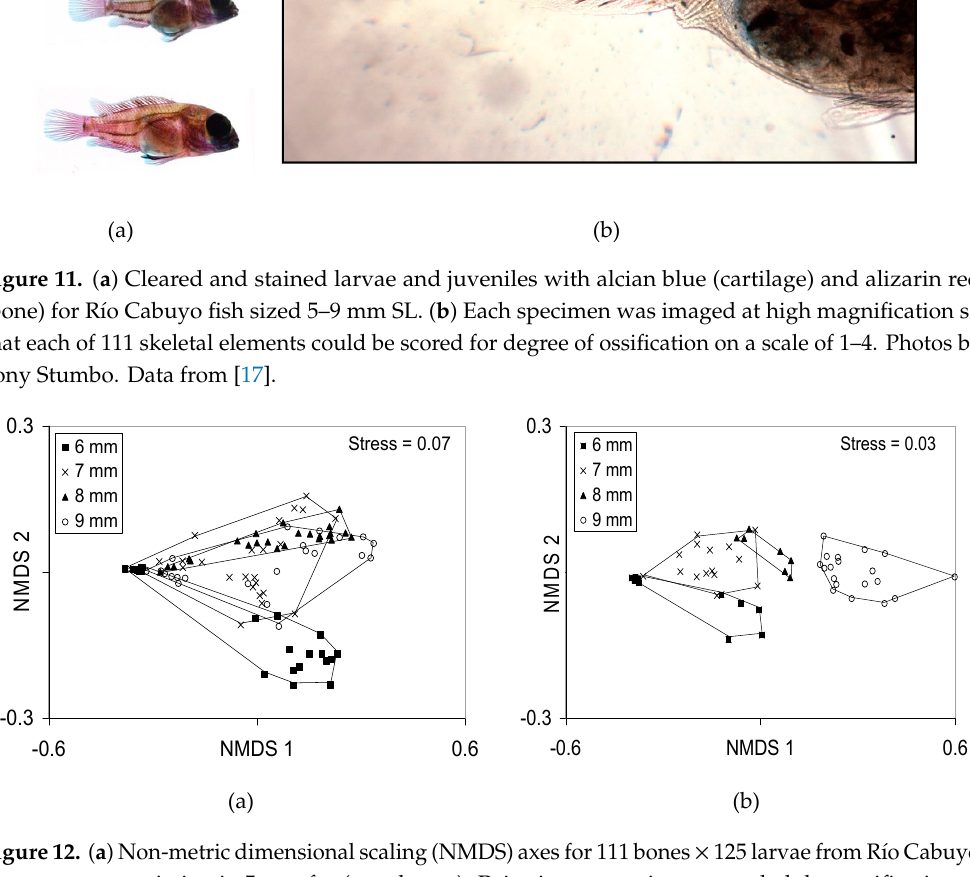
Figure 12. ( a ) Non-metric dimensional scaling (NMDS) axes for 111 bones × 125 larvae from Río Cabuyo. There was no variation in 5 mm fry (not shown). Pairwise comparisons revealed that ossification of 6 mm fry < 7 = 8 = 9 mm SL fry. ( b ) NMDS ordination of images from larvae from lab-F1 adults from Laguna de Xiloá. Again 5 mm SL fish contained no variation (not shown), but the conspicuous shift in ossification was between 8 mm fry and 9 mm fry. Data from [17,21].